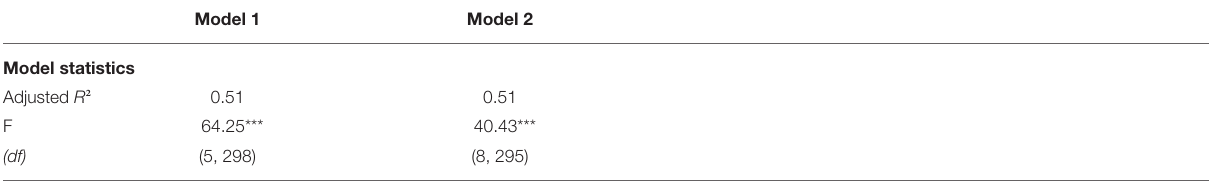
TABLE 4 | Multiple regression analyses for predicting